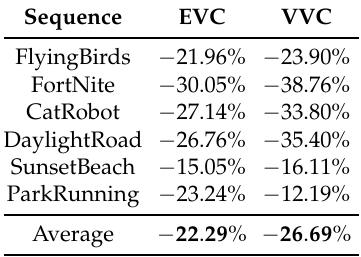
Table 4. Bjontegaard-Delta Bit-Rate (BD-BR) with respect to High Efficiency Video Coding